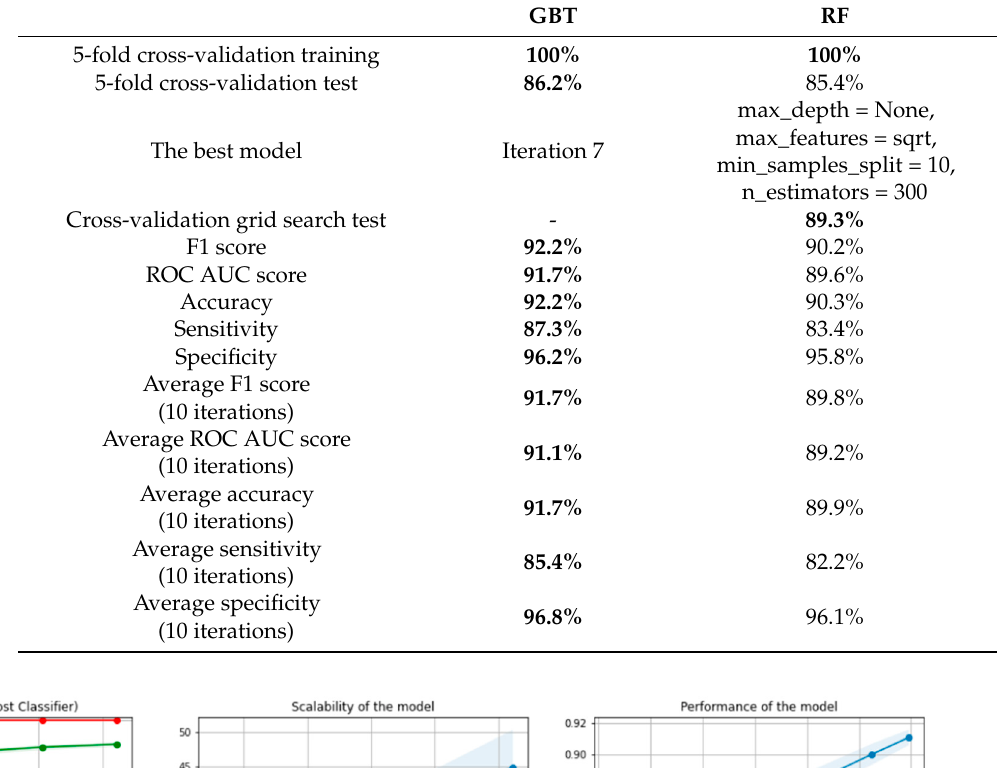
Table 6. Results of the DT algorithms applied on the overlapping dataset.